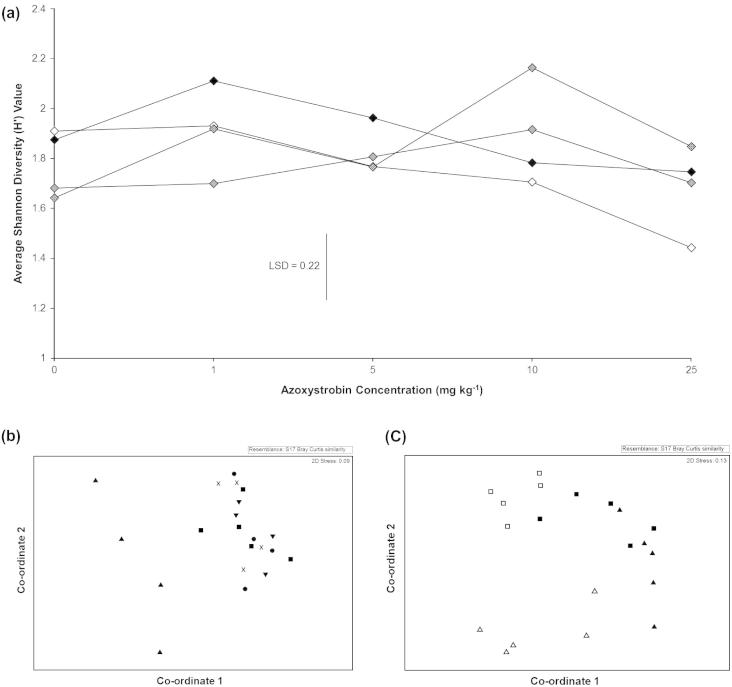
(a) The average Shannon diversity index (H′) of nematode communities recorded using the Nem 18Sf/Nem 18Sr primer pair over 4 months following azoxystrobin application. ♦ 1 month ♢ 2 months  3 months  4 months. Each data point represents the mean of 4 experimental samples at an individual time point. (b) NMDS analysis of fungal community structure determined using primer pair EF4f and EF3r and grouped by Azoxystrobin concentration. ■ 0 mg kg−1 ▾ 1 mg kg−1 ● 5 mg kg−1 × 10 mg kg−1 ▴ 25 mg kg−1. Each data point represents the mean of 4 experimental replicates. (c) NMDS analysis of fungal community structures using extracted DNA and RNA 1 month post azoxystrobin application. Each data point represents an experimental replicate. ■ 0 mg kg−1 DNA □ 25 mg kg−1 DNA ▴ 0 mg kg−1 RNA Δ 25 mg kg−1 RNA.